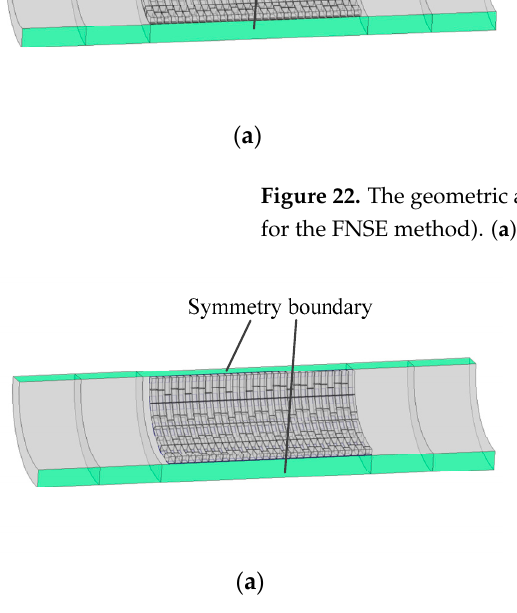
Figure 23. The geometric and detailed FE models of the ADCAA system with grazing flow (suitable for the IBNSE method). ( a ) Geometric model and ( b ) FE model.